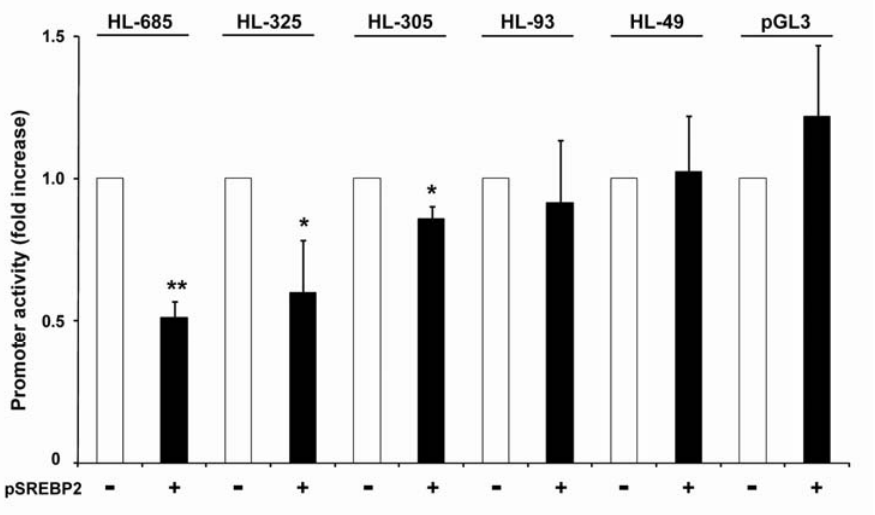
Figure 5. Effect of 5 ′ -deletions on the down-regulation of HL-685 activity by nSREBP2. HepG2 cells were co-transfected with the indicated HL constructs (or empty pGL3-basic) without (-) or with (+) 6 ng pSREBP2. Luciferase activity was determined after 72h. The activity without pSREBP2 was taken as 1.0 (n = 3–4; *: P < 0.05, ** P < 0.01 vs.